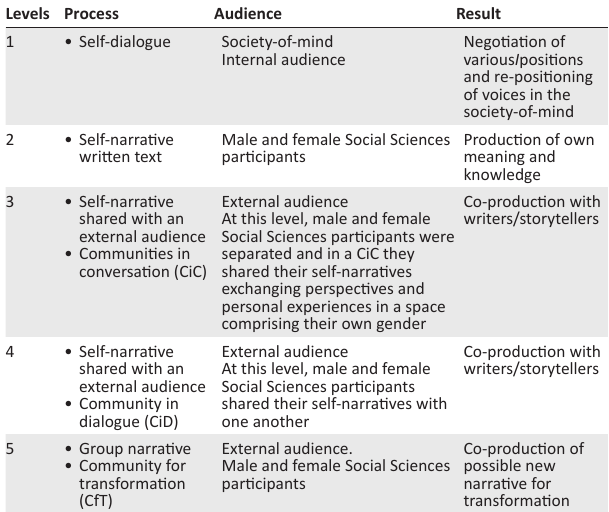
TABLE 1: Empathetic-Reflective-Dialogical Restorying – Five